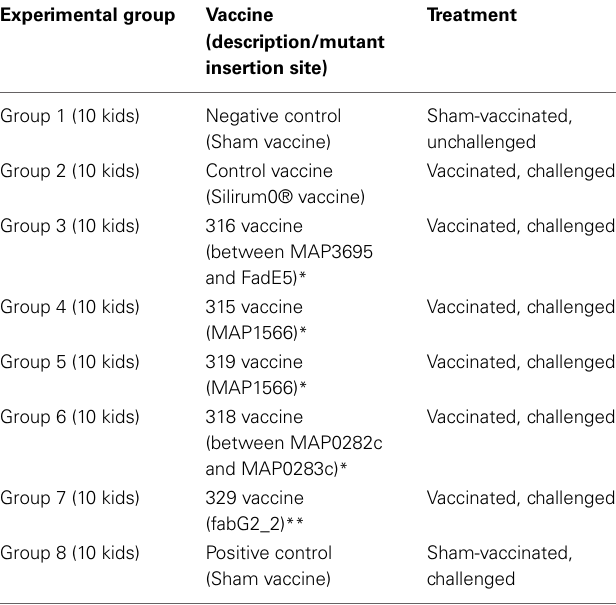
Table 1 | Summary of experimental design and